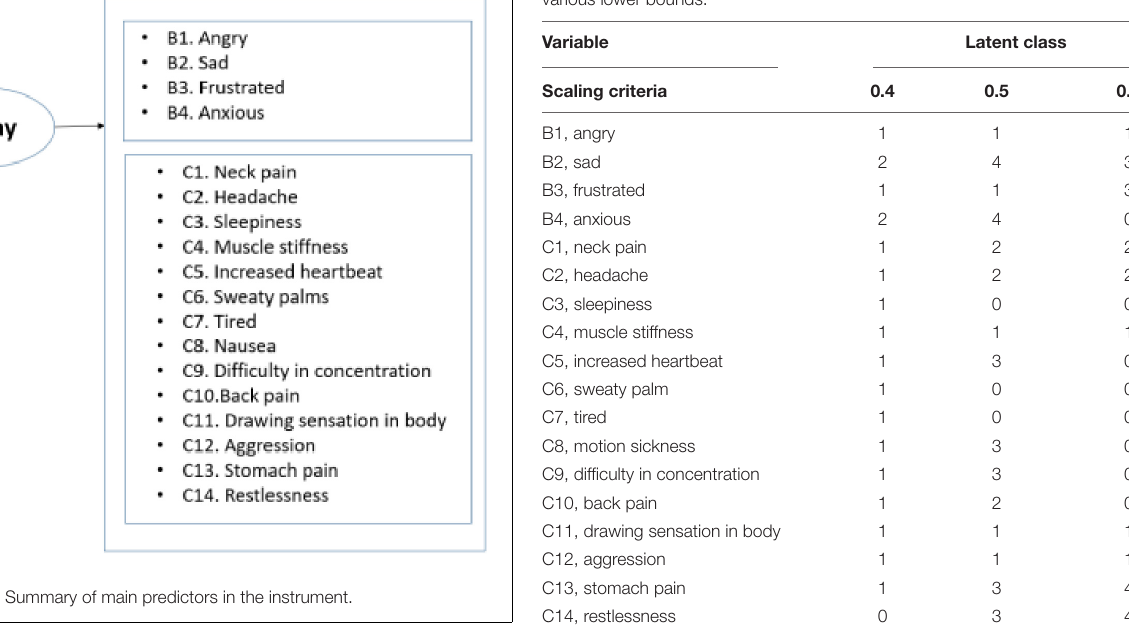
TABLE 1 | The automated item selection procedure (AISP) results based on various lower